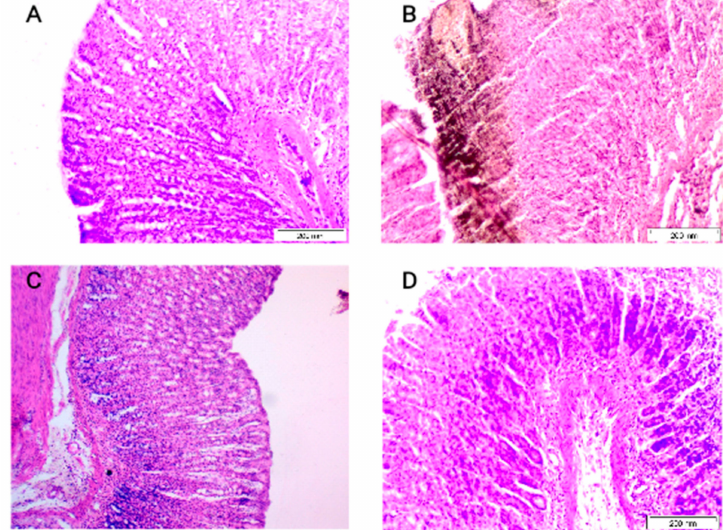
Figure 10. Representative photomicrographs of hematoxylin and eosin (H&E)-stained stomachs of: ( A ) control: showing normal mucosal thickness with intact mucosa and more gastric glands; ( B ) Indomethacin-treated (ulcer model): showing acute gastritis grade I in the form of an area of superficial ulceration, congested mucosa with focal lymphocytic inflammatory infiltrates; ( C ) pure ellagic acid + indomethacin showing mild damage with no surface mucosal ulceration and few inflammatory cellular infiltrates in the form of lymphocytes; ( D ) ellagic acid formula + indomethacin: showingmucousglandsofthefundicregionwithoutsuperficialulcerationorintraepitheliallymphocytic infiltrates in the lamina propria. (Magnification = 200 × ). H&E